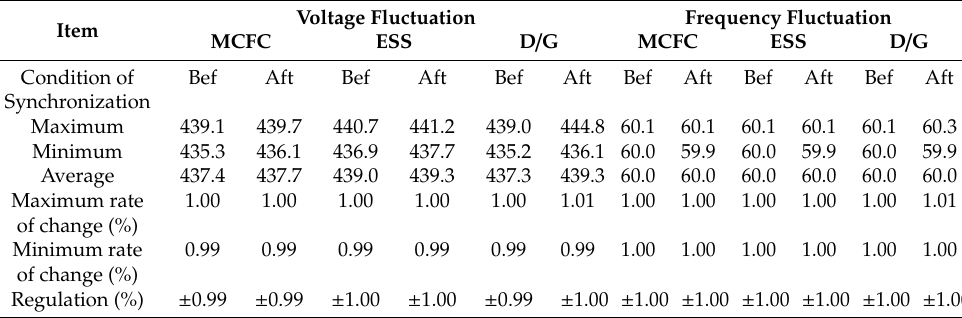
Table 18. Power data analysis before and after diesel generators